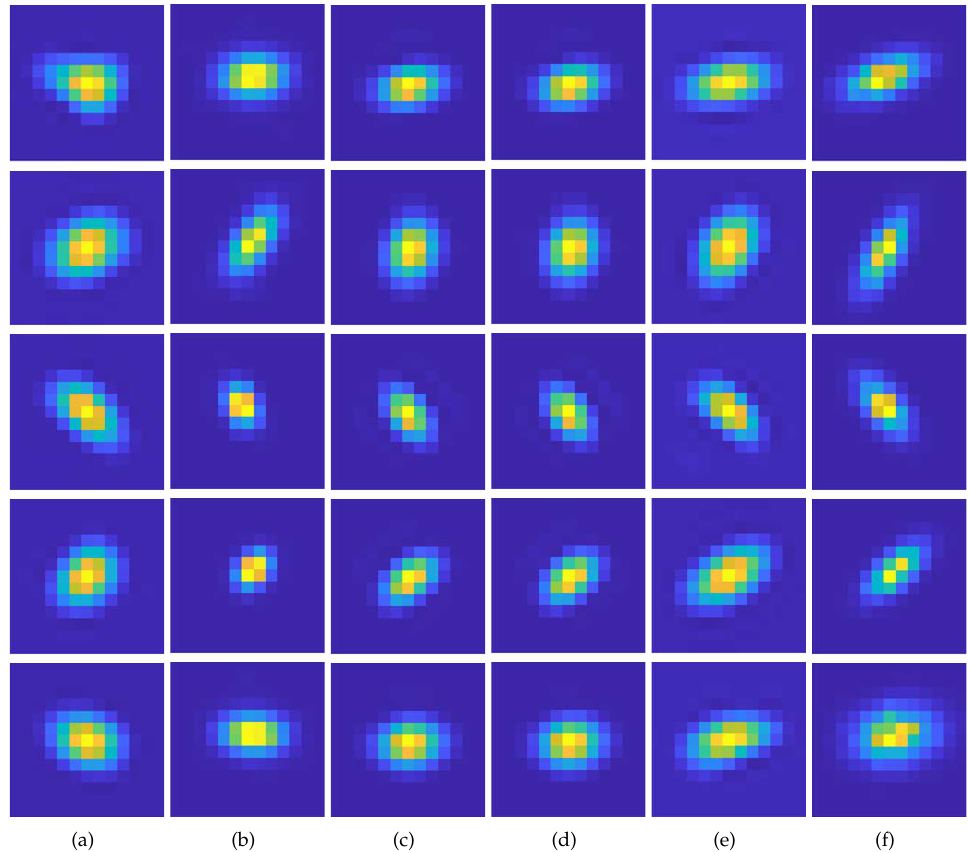
Figure 6. Qualitative results of the kernel estimation for scale factor of × 2 for Flickr2KRK dataset. ( a ) KernelGAN [20], ( b ) FKP [21], ( c ) E-KernelGAN [22], ( d ) E-KernelGAN-DIP [22], ( e ) TVG- KernelGAN, ( f ) GT.